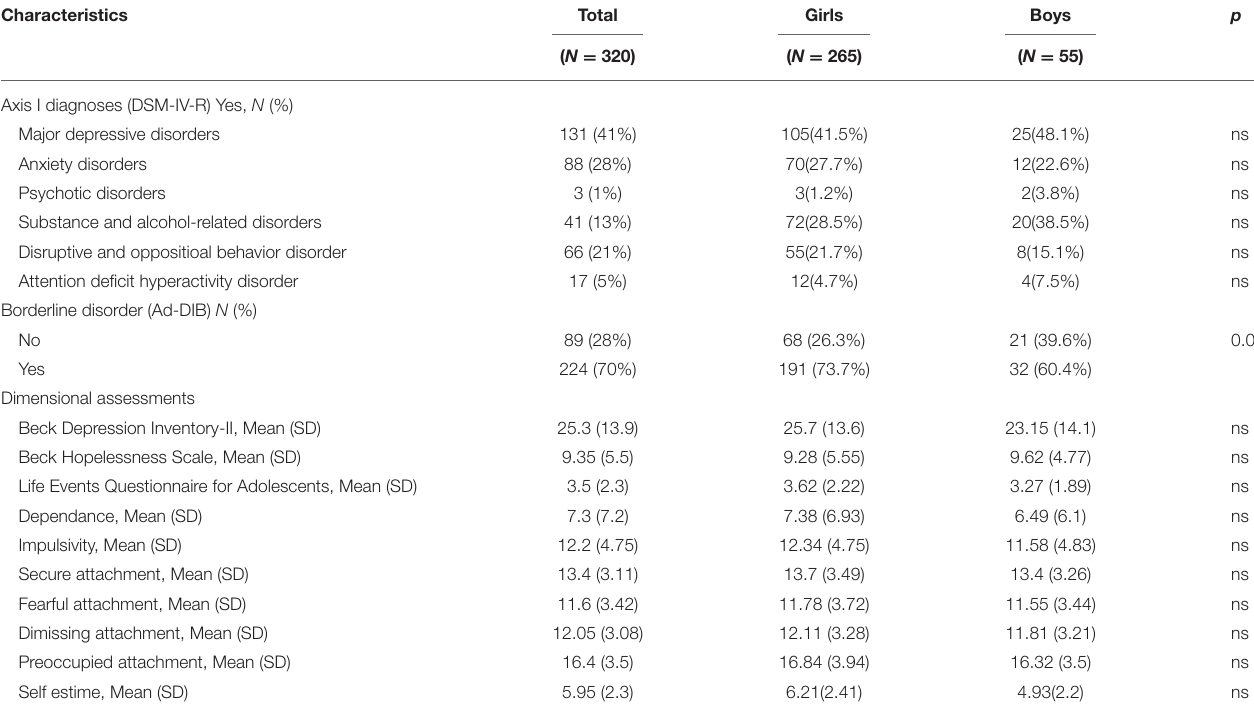
TABLE 3 | Individual risk factors and comparisons by gender.